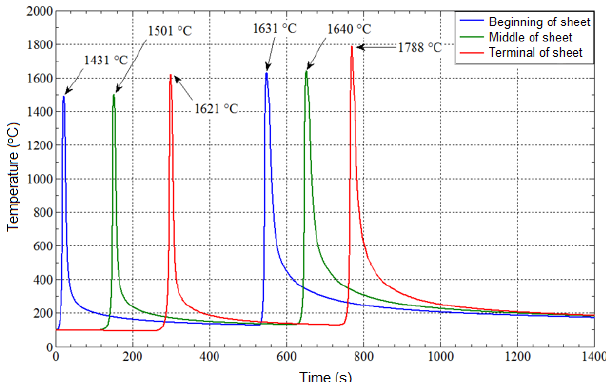
Figure 10. Temperature gradient obtained when the virtual source of heat is in the middle of the second welding pass.